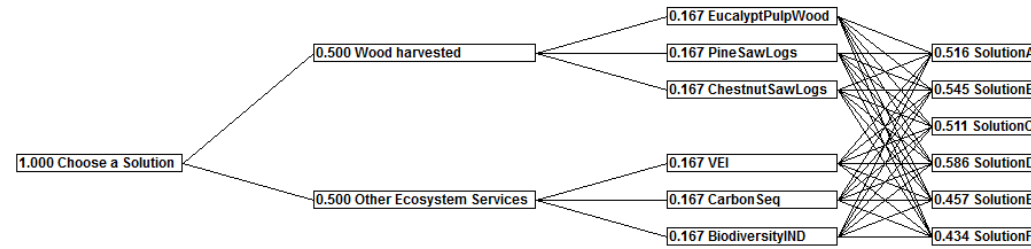
Figure 4. The Criterium DecisionPlus (CDP) model to choose the best nondominated point from the Pareto frontier.